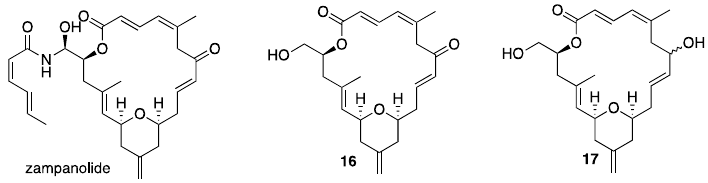
Figure 2. Zampanolide and analogues of the structurally related dactylolide natural product.